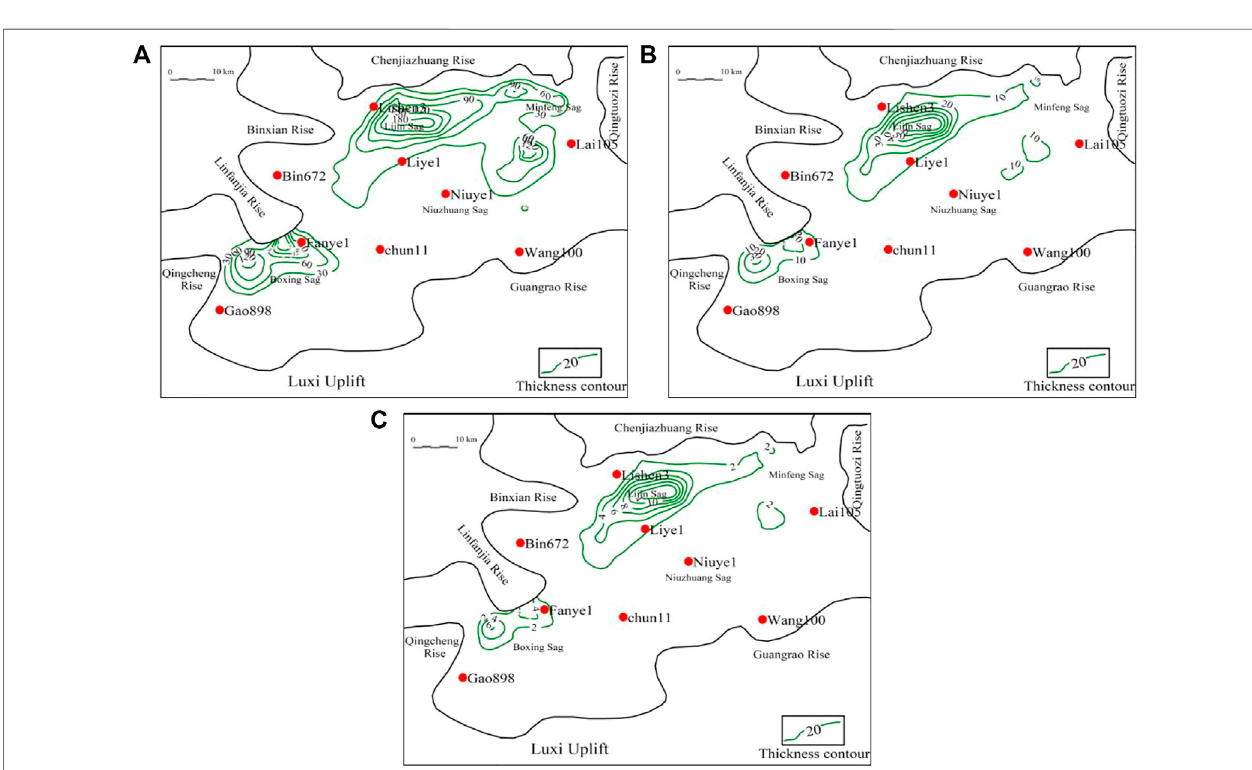
FIGURE 9| Resource abundance contour map of the Shahejie Formation Es3x in the DongyingSag (A) : total resource abundance; (B) : free resource abundance; (C) : movable resource abundance).